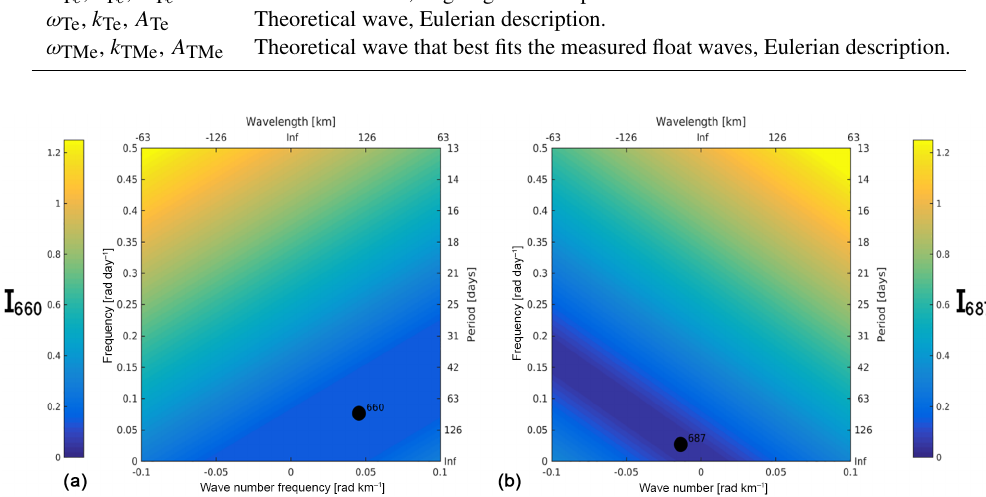
Table 2. Summary of the different notations of the wave properties: frequency ω , wave number k and amplitude A . ω M (cid:96) , k M (cid:96) , A M (cid:96) Measured float wave, Lagrangian description.